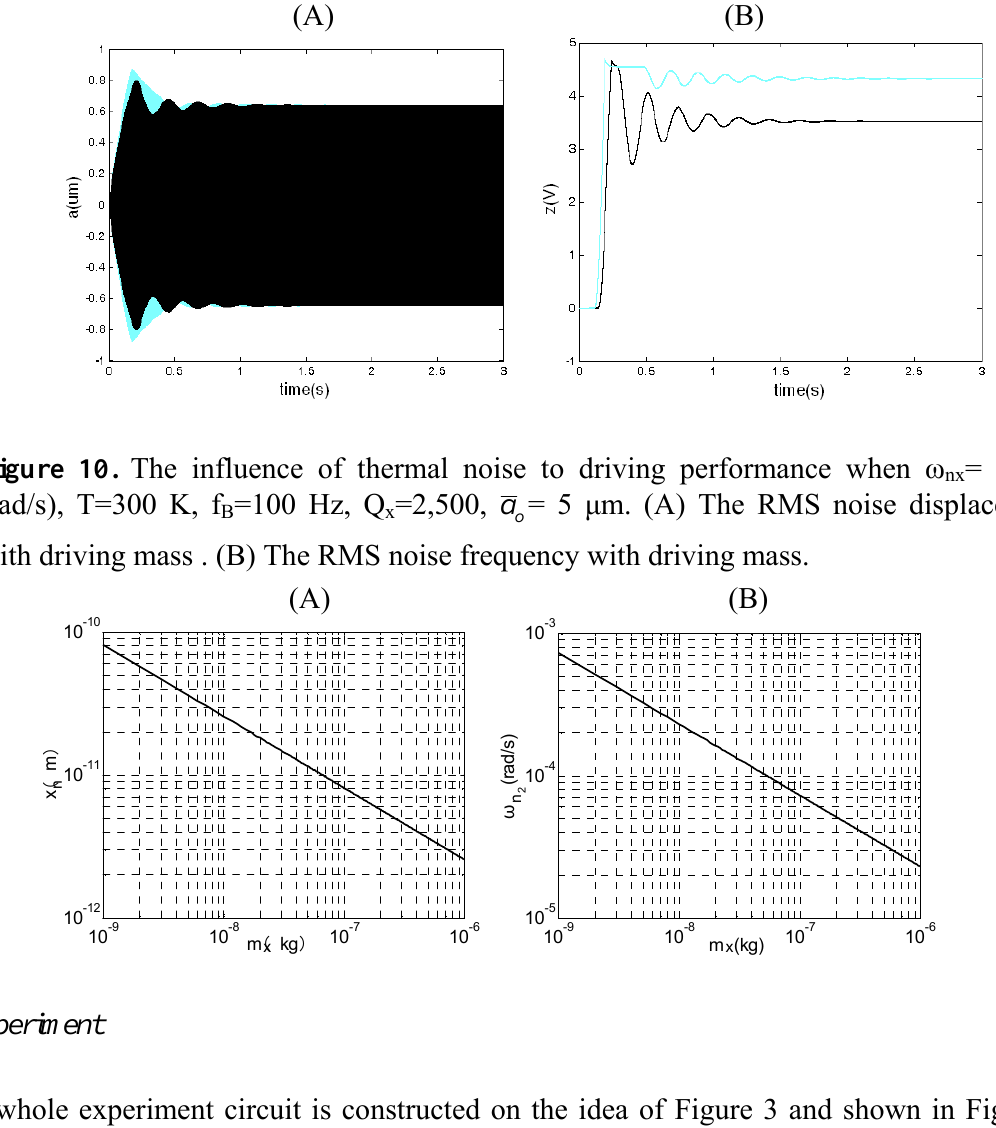
Figure 9. The simulation curve of closed-loop driving in Q (gray) when 0.3 V V   . (A) The curve of the drive displacement with time. (B) The ref refo curve of the output of integrator z(t) with time.